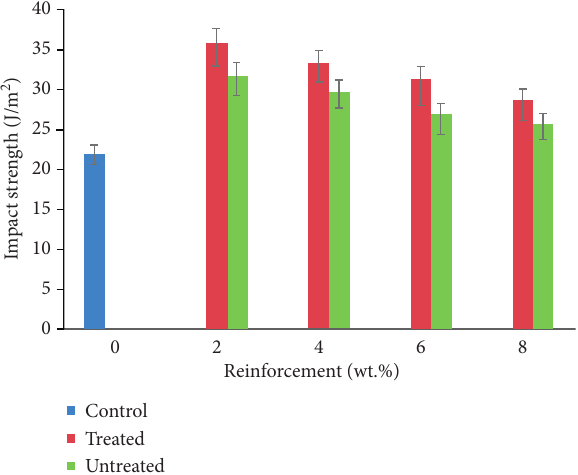
Figure 8: Variation in impact strength of coir fibre and yam peel particulate polyethylene